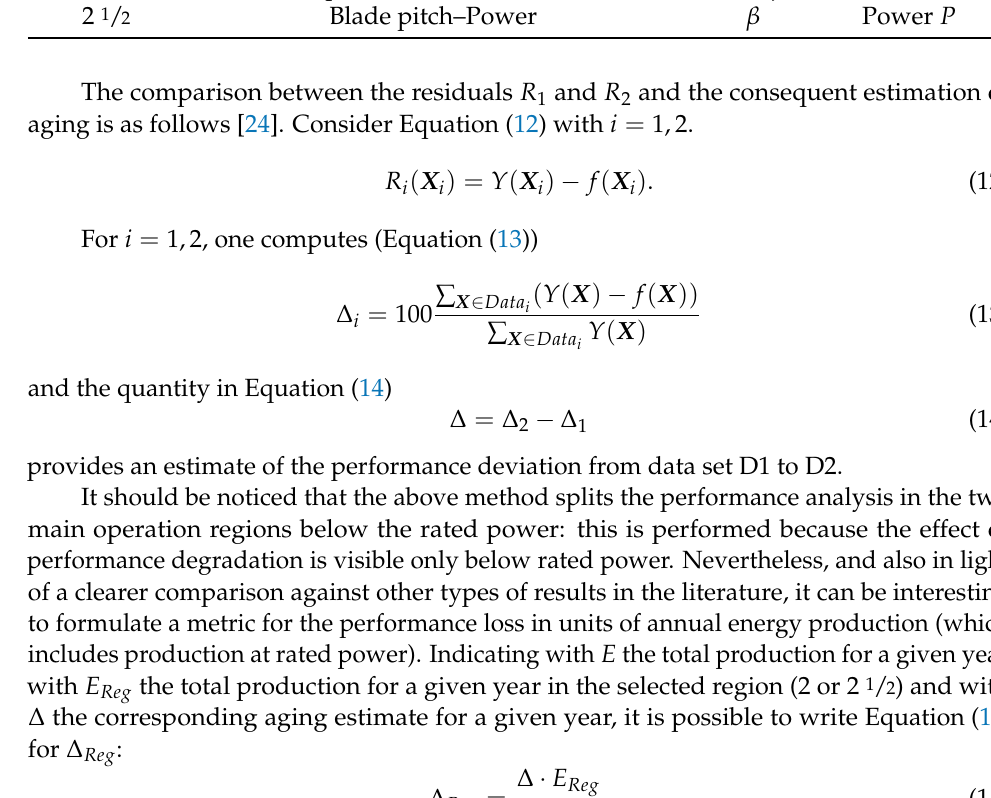
Table 3. Structure of the SVR regressions for each operation curve. Region Curve Input Output 2 Generator speed–Power Ω Power P Rotor speed–Power ω Power P Generator speed & Blade Pitch–Power Ω & β Power P Rotor speed & Blade Pitch–Power ω & β Power P 2 1 / 2 Blade